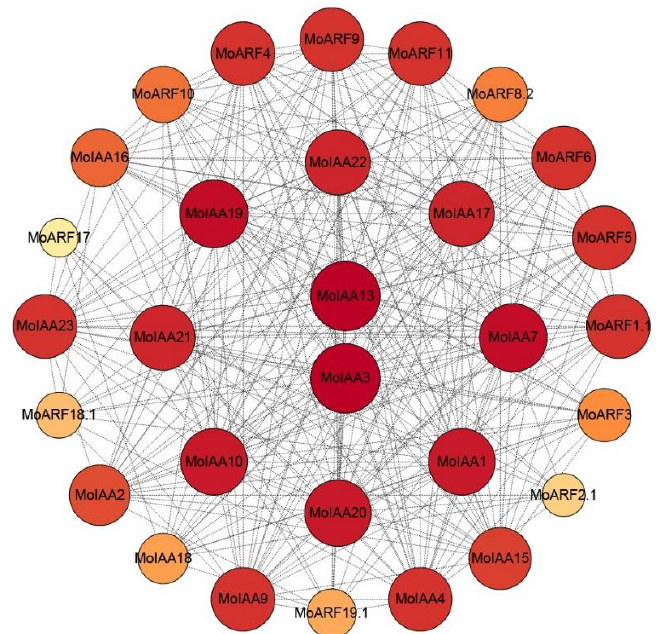
Figure 5. Protein–protein interaction network for the MoIAA and MoARF gene family; the network contains 30 nodes, and darker colors and larger nodes represent more interaction with others.